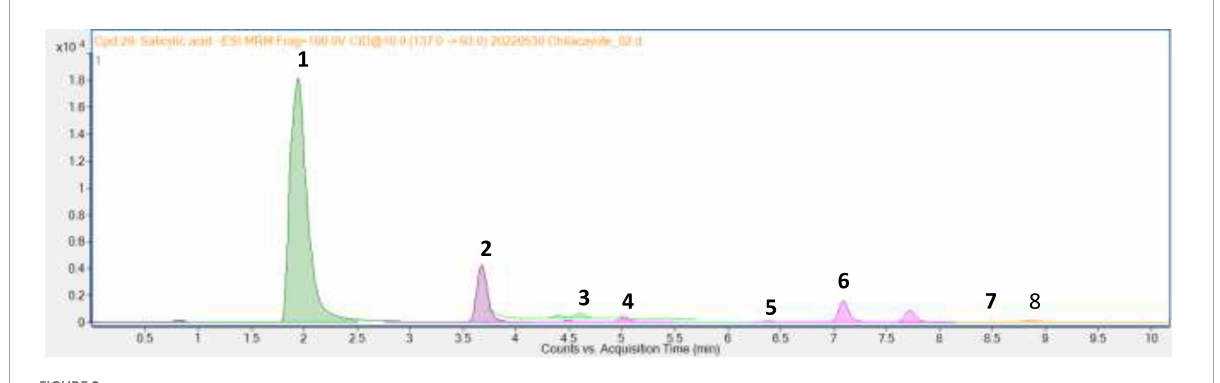
FIGURE2 Chromatogram of methanol extract of C. ficifolia pulp where: 1, L-phenylalanine; 2, 4-hydroxybenzoic acid; 3, 4-hydroxyphenylacetic acid; 4, vanillic acid; 5, vanillin; 6, 4-coumaric acid; 7, ferulic acid; 8, ferulic